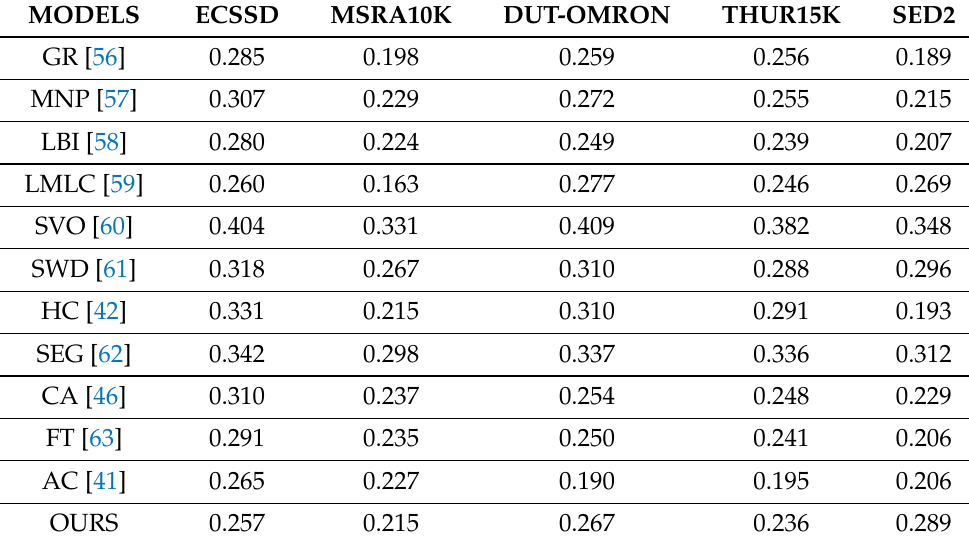
Table 4. Our model’s MAE results compared with some state-of-the-art models from Borji et al. [48] (for MAE, the smaller value is the